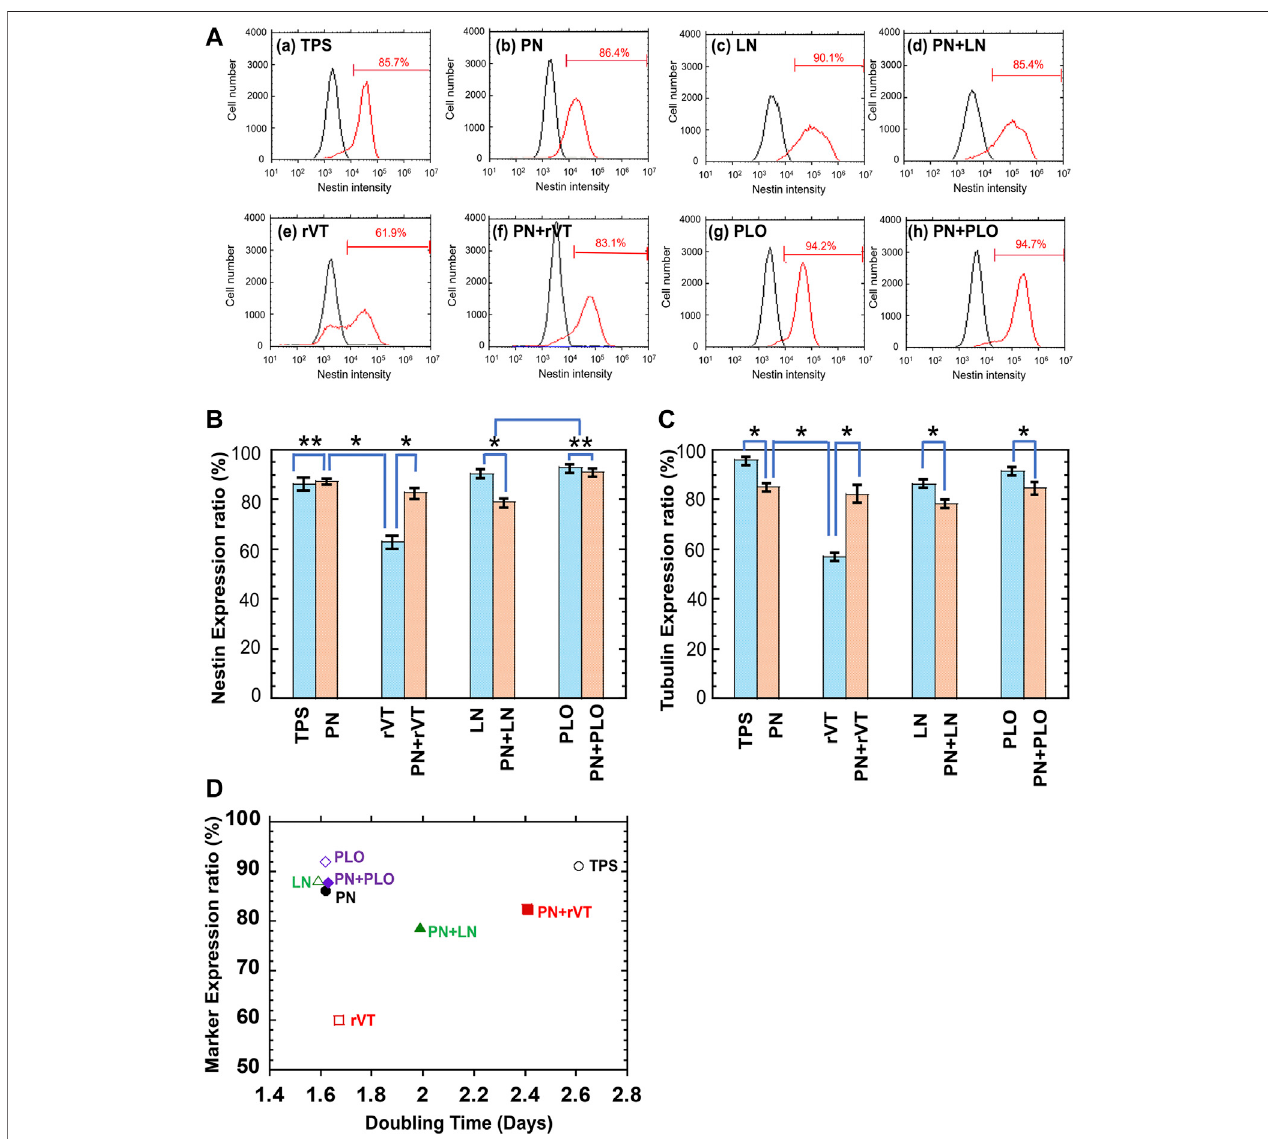
FIGURE 6 | Characterization of DPSCs-derived neuronal cells after fi ve passages of DPSCs cultivation on TPS, TPS-PN, TPS-ECM, TPS-PLO, TPS-PN-ECM and TPS-PN-PLOplates. (A) FlowcytometryspectraofnestinexpressiononDPSCs-derivedneuronalcellscultivatedonTPS (a) ,TPS-PN (b) ,TPS-LN (c) ,TPS-PN-LN (d) ,TPS- rVT (e) ,TPS-PN-rVT (f) ,TPS-PLO (g) andTPS-PN-PLO (h) plates. (B) NestinexpressionratioculturedonDPSCs-derivedneuronalcells,whichwerecultivatedonTPS,TPS- PN, TPS-ECM, TPS-PLO, TPS-PN-ECM and TPS-PN-PLO plates. * p < 0.05. ** p > 0.05. (C) β III tubulin expression ratio cultured on DPSCs-derived neuronal cells, which were cultivated on TPS, TPS-PN, TPS-ECM, TPS-PLO, TPS-PN-ECM and TPS-PN-PLO plates. * p < 0.05. (D) Dependence ofthe averaged neuronal expression of DPSC-derived neuronal cells on the doubling time of DPSCs cultured on TPS, TPS-PN, TPS-ECM, TPS-PLO, TPS-PN-ECM and TPS-PN-PLO plates.